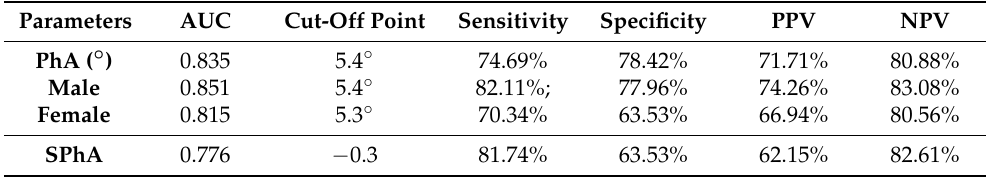
Table 2. Diagnostic accuracy of different parameters to detect malnutrition in admitted